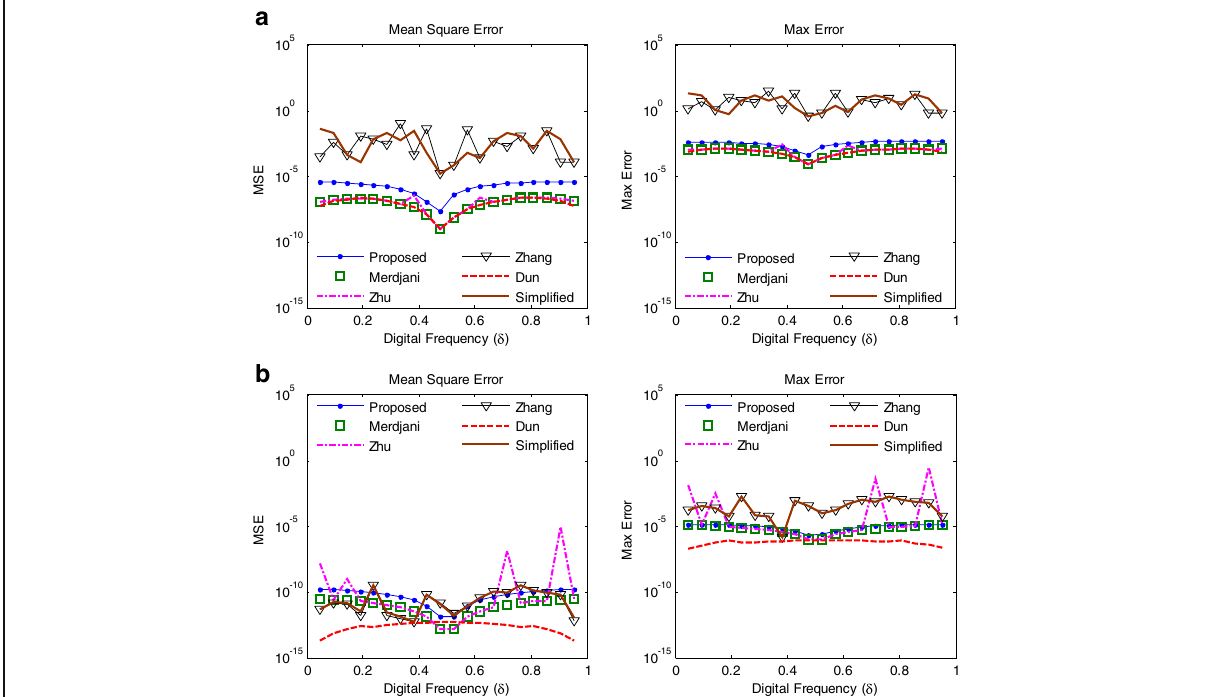
Fig. 1 MSE comparison of the estimators for single-tone sinusoidal input without noise. Two sets of the sinusoidal signal were used. The results of the two sets are presented in ( a ) and ( b ). We set l 0 = 46 for ( a ) and l 0 = 510 for ( b ). There were averages of 10,000 runs for each frequency